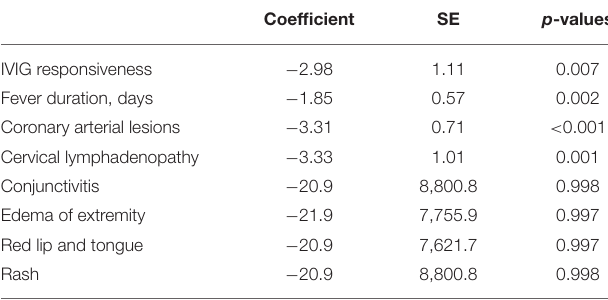
TABLE 4 | Results of regression analysis of CD56 − CD16 + natural killer cells: correlations with the clinical manifestations of intravenous immunoglobulin